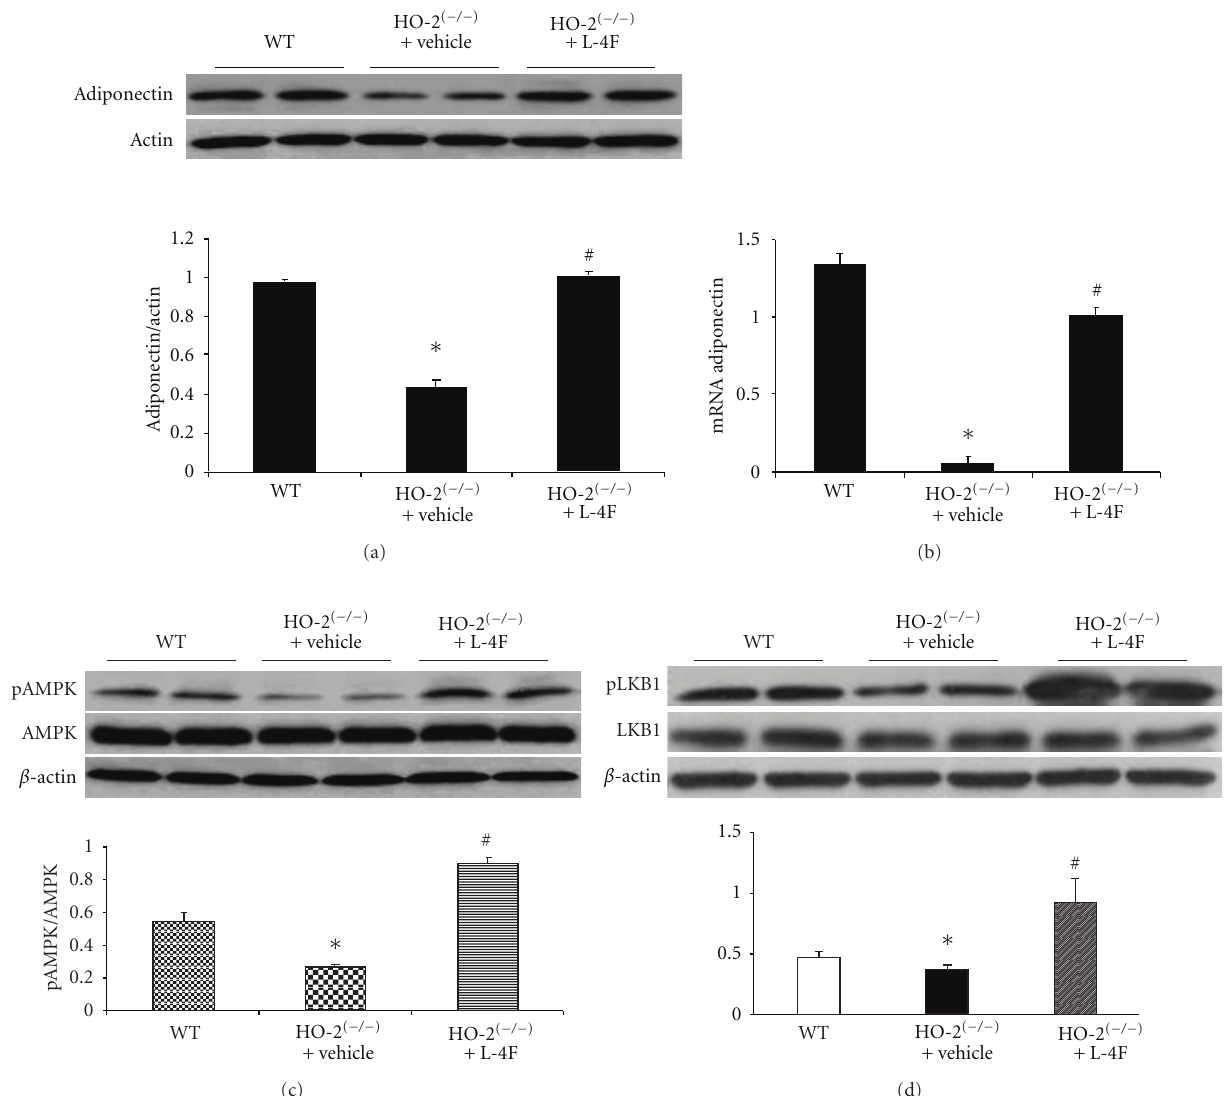
Figure 4: E ff ect of L-4F on adiponectin pAMPK and LKB1 expression in HO-2 null. L-4F was administered daily for 6 weeks and liver tissues analyzed for adiponectin protein (a) and mRNA (b) expression. Protein bands were analyzed by densitometry and plotted against a relative expression to actin. Results are means ± SE, n = 6, ∗ P < 0 . 05 versus WT, # P < 0 . 05 versus HO-2 ( − / − ) . (c) Western blot and densitometry analysis of hepatic tissues for pAMPK and AMPK. Values are means ± SE, n = 5, ∗ P < 0 . 05 versus WT, # P < 0 . 05 versus HO-2 ( − / − ) . (d) Expression for LKB1 in WT, HO-2 KO with and without L-4F. Values are means ± SE, n = 6, ∗ P < 0 . 05 versus WT, # P < 0 . 05 versus HO-2 ( − / − )